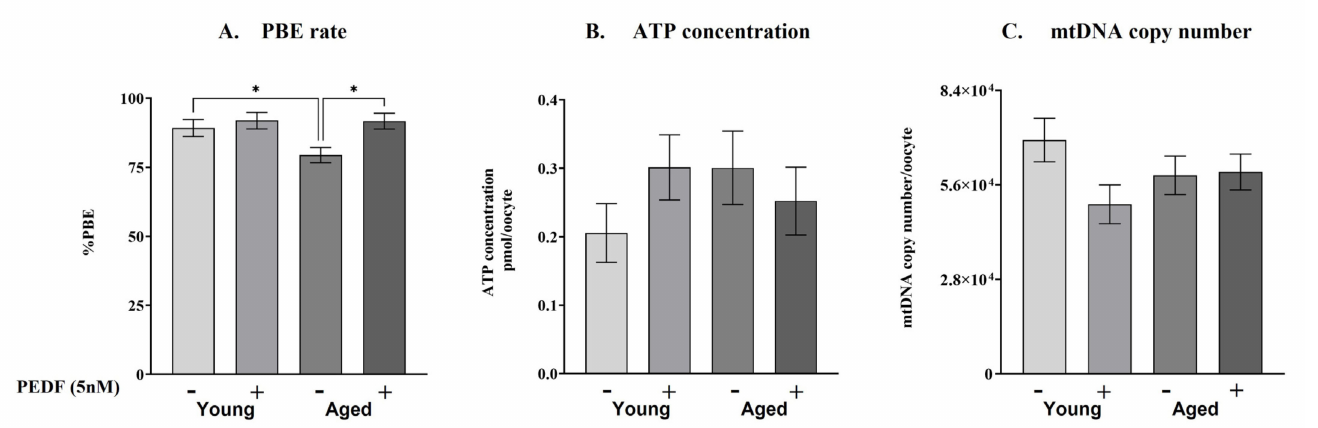
Figure 4. PBE rate, ATP concentration, and mtDNA copy number in mouse oocytes matured in vitro. GV oocytes were isolated from individual young (“Young”; 6–8 weeks old) and RA (“Aged”; 40–46 weeks old) ICR female mice, primed for 48 h with PMSG (5IU or 7.5 IU, respectively) and subjected to IVM with (+) or without ( − ) 5 nM rPEDF. ( A ) After 20 h of IVM, the PBE rate was calculated and recorded for each mouse individually. Total number of oocytes in each group: n ≥ 84. ( B , C ) MII oocytes (after IVM) were individually collected, lysed, and subjected to analysis of ATP concentration or mtDNA copy number. Total number of oocytes per experimental group: n ≥ 19. Each group contained oocytes from at least four mice. Data are presented as mean ± SEM. Results were analyzed by one-way ANOVA with FDR correction, * pv <